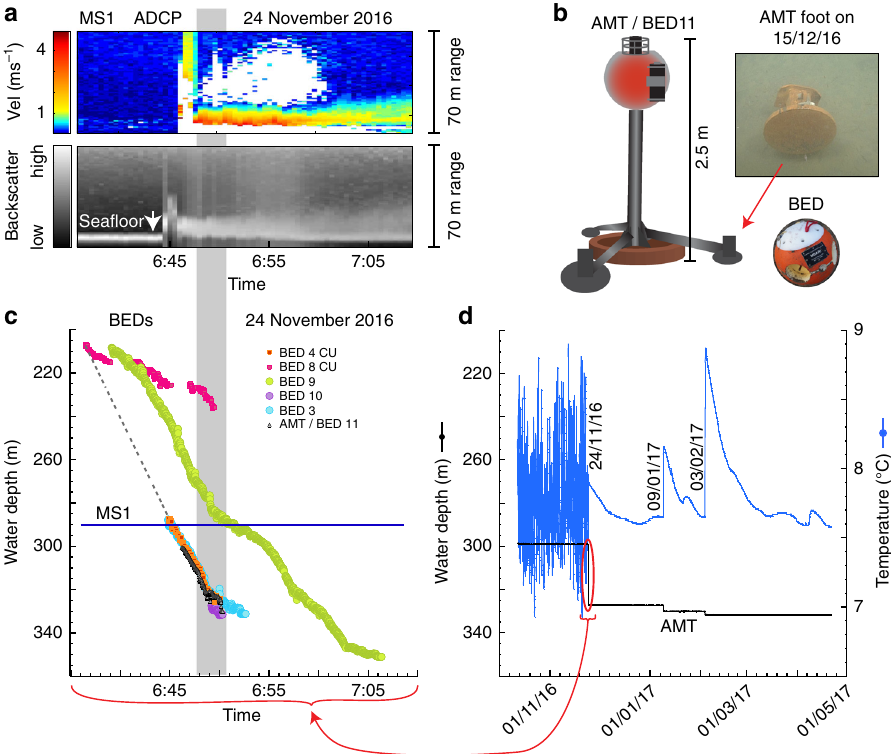
Fig. 4 24 November 2016 fl ow event records. a Thirty- fi ve-minute-long record of ADCP-measured velocity and backscatter recorded on mooring MS1 during the 24 November 2016 fl ow event. b Images of a round BED and the 800-kg tripod frame with BED11 and AMT attached. Also shown is one foot of the tripod frame, exposed above the sea fl oor after the event. c Changes in depth of 6 BED instruments during the 24 November 2016 fl ow event for the same time period shown in a . Dotted line connects initial bed movements, which are used to calculate the transit velocity through this depth interval. Gray area in a and c indicates period when all six instruments were moving simultaneously. d Plot of depth and temperature vs. time from the AMT (sampled every 45 min) during the third deployment (Fig. 3). The range of water depth shown in c and d are equivalent. The red oval indicates the time interval shown in